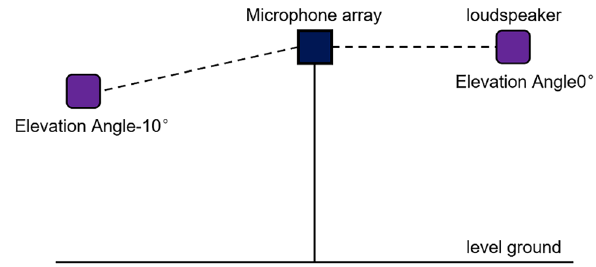
Figure 4. Acquisition of